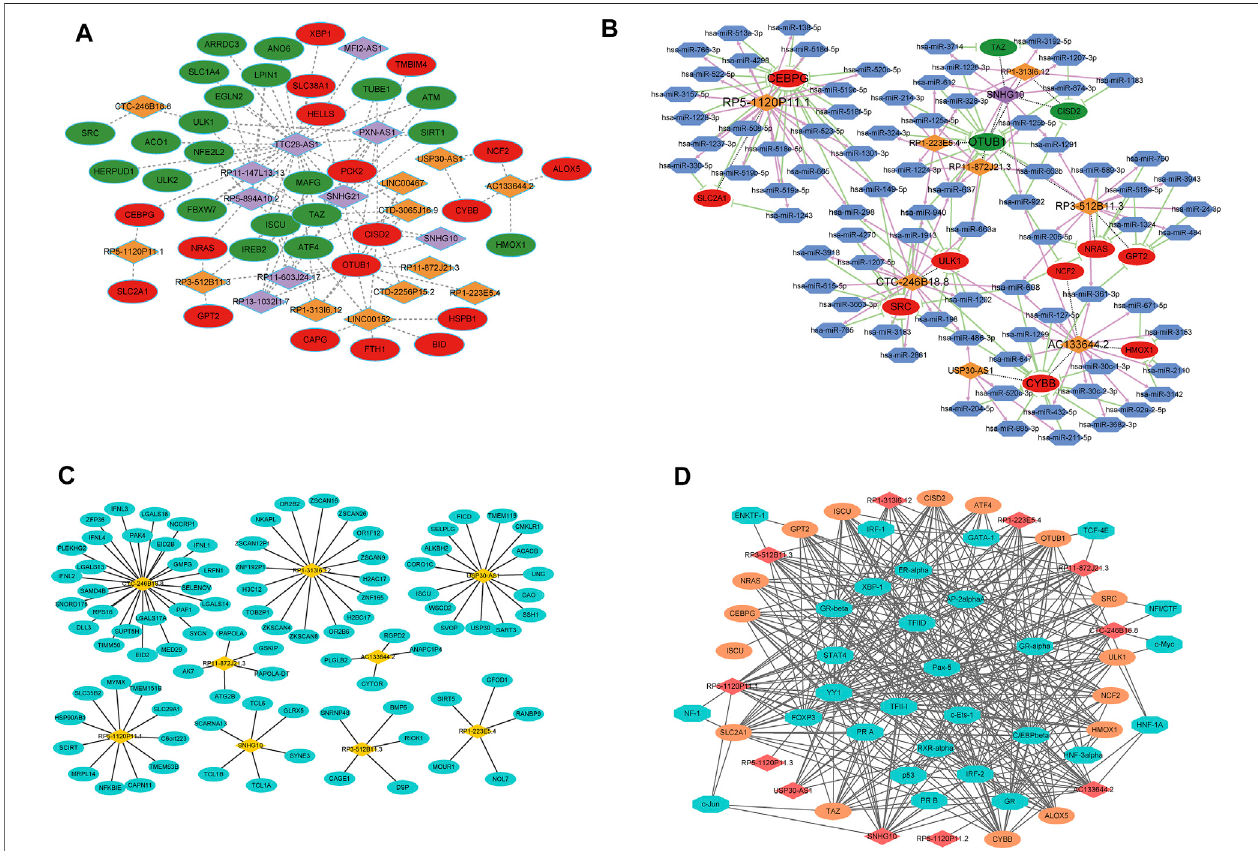
FIGURE 9 | Network analyses (A) FRG-FRL co-expression network. Ellipses: FRGs; rhombus: FRLs (B) ceRNA network. Ellipses: FRGs; rhombus: FRLs; hexagon: miRNAs (C) lncRNA-nearby mRNA interaction networks. Rhombus: FRLs; ellipses: nearby mRNAs (D) Trans interaction for lncRNA-TF-mRNA relationship pairs. Rhombus: FRLs; ellipses: mRNAs; octagon: